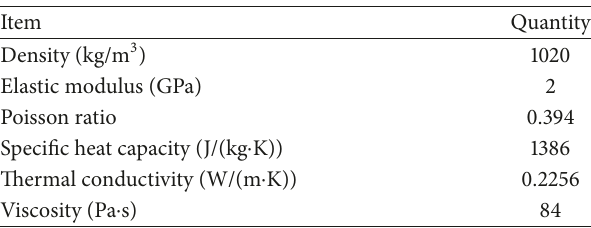
Table 2: Properties of ABS material.